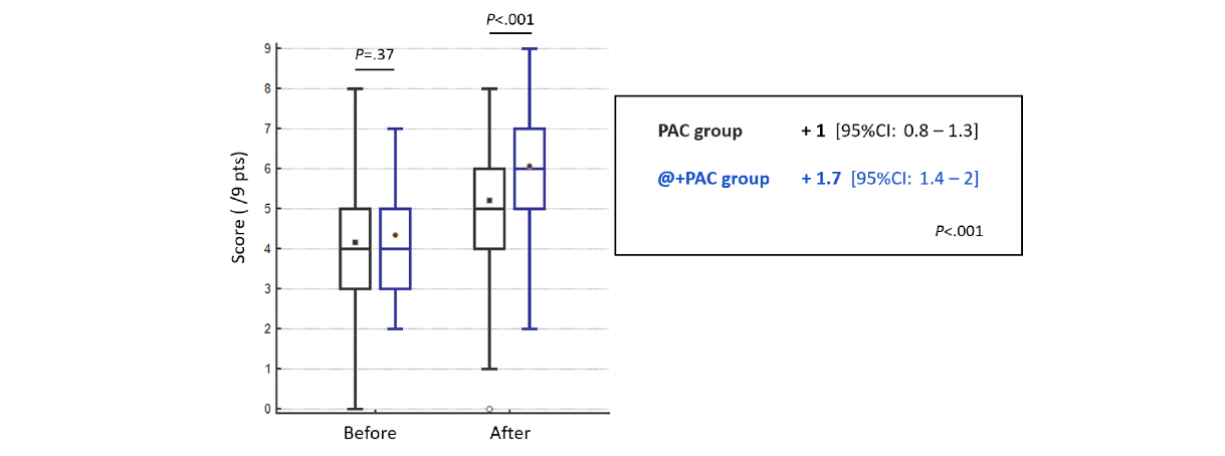
Figure 4. Comparison of anesthesia knowledge test scores between patient groups. Means are shown as markers within the box of 25th and 75th percentile values; whiskers represent ranges. PAC: preanesthetic consultation; @+PAC: digital conversational agent and preanesthetic consultation; pts: